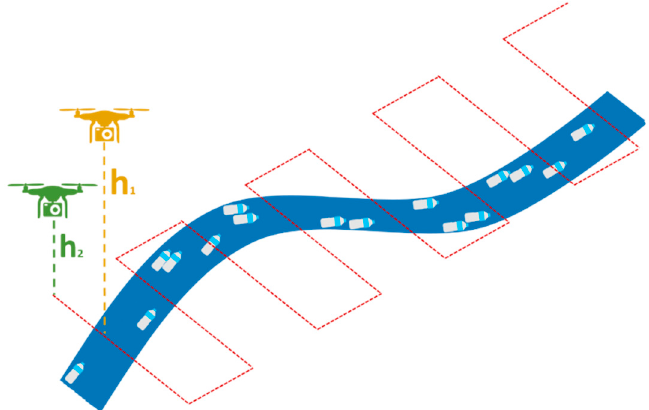
Figure 11. Proposed flight planning methodology to obtain accurate datasets for algorithm calibration.